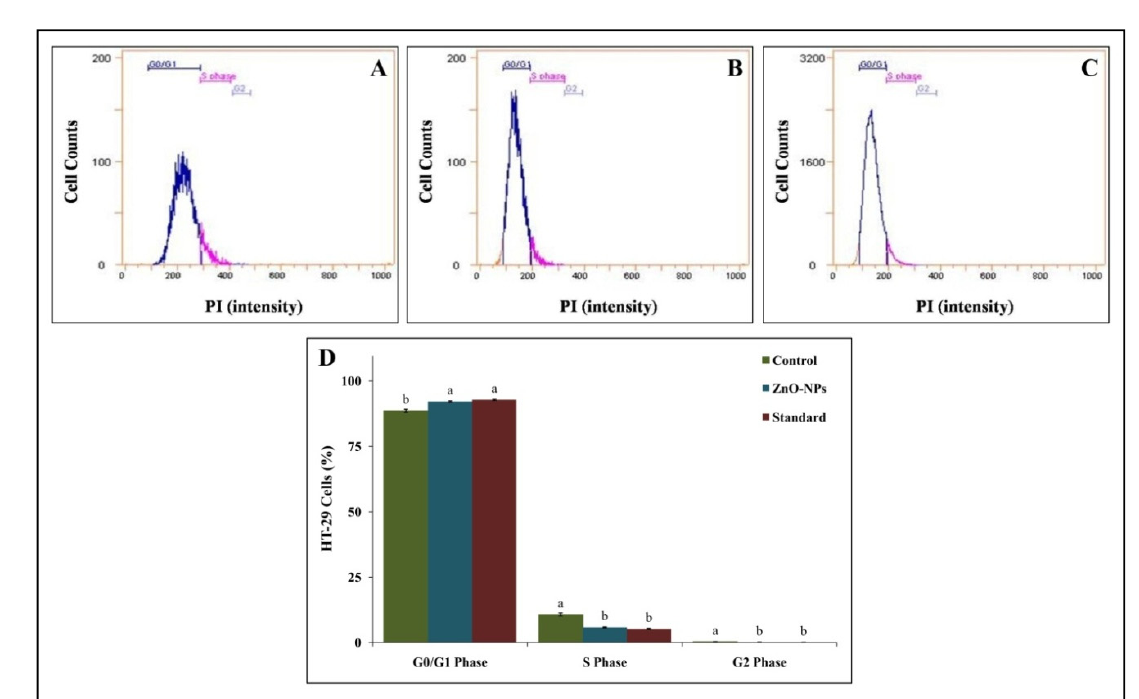
Figure 10. Representative graph of flow cytometry of HT-29 cell cycle analysis. ( A ): Control; ( B ): ZnO-NPs; ( C ): Colchicine; ( D ): Percentage of HT-29 cells. Each value is the mean of three replicates (n = 3) and bars sharing the same letters are not significantly different ( p ≤ 0.05) according to Tukey’s HSD. The vertical bar indicates the standard error. Molecules 2020 , 25 , x FOR PEER REVIEW